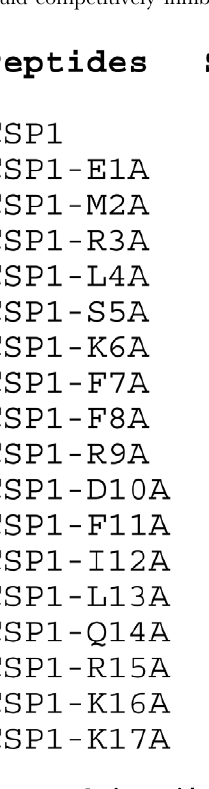
Figure 1. Amino acid sequences of CSP1 and its analogs. Analogs were synthesized based on the sequence of CSP1 by alanine substitutions.